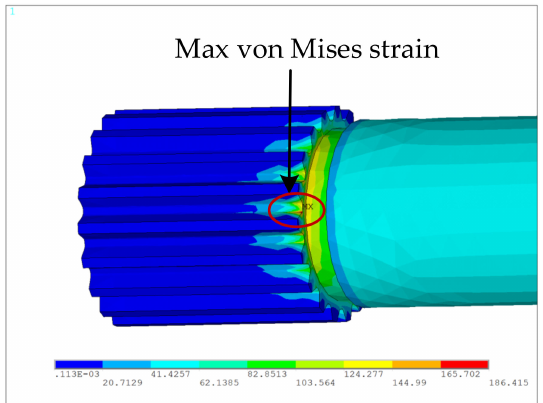
Figure 7. Distribution of the von Mises strains of spline shaft model.